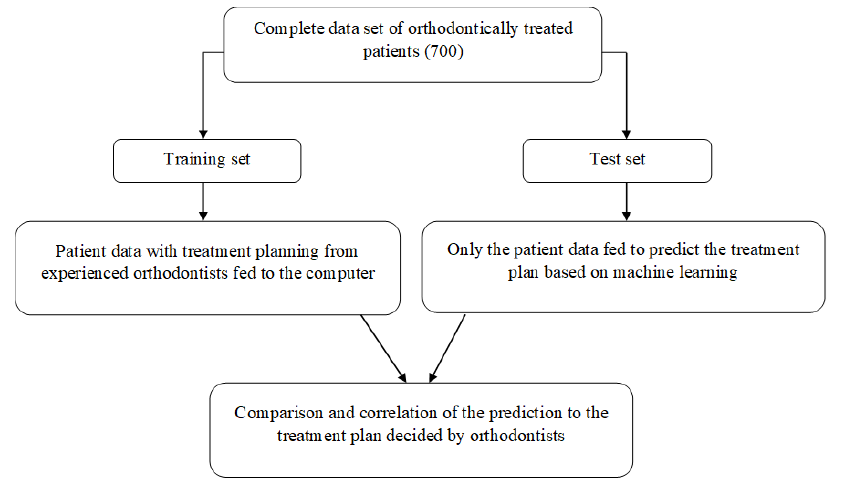
Figure 3. Methodology.